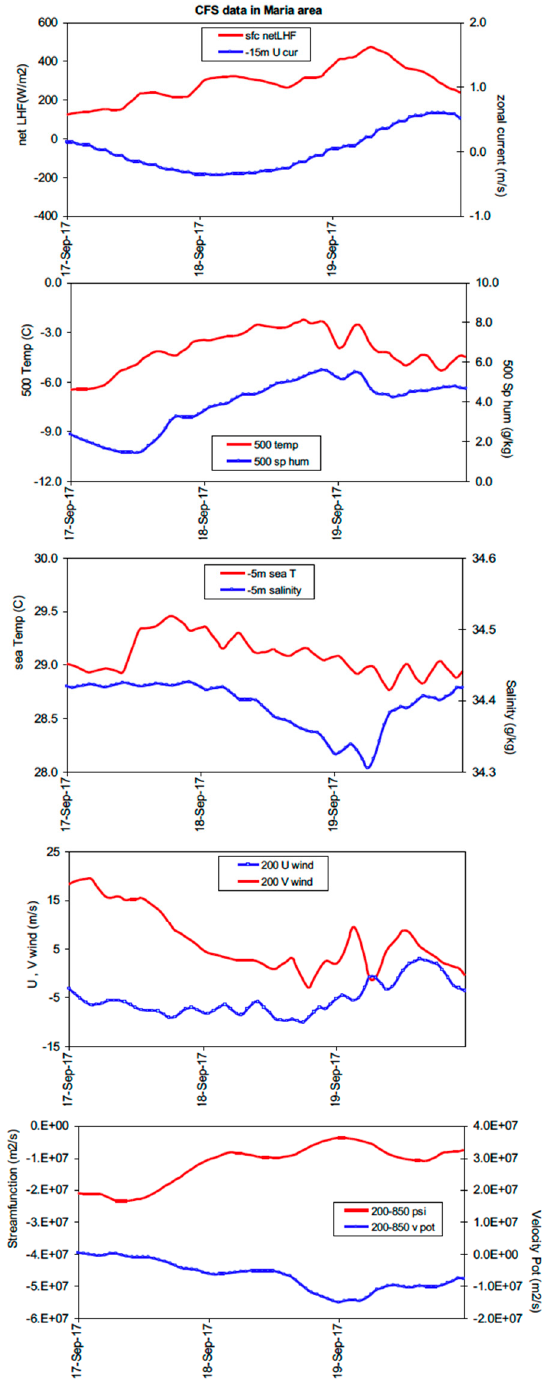
Figure A1. Time series of CFSr2 hourly data averaged in the intensification area (box in Figure 5c) over the period 17–19 September 2017 (top-down): Net LHF and –15m current, 500 hPa temp and spec hum., –5 m sea temp and salinity, 200 hPa U and V wind, 200–850 hPa (difference) streamfunction, and velocity potential.